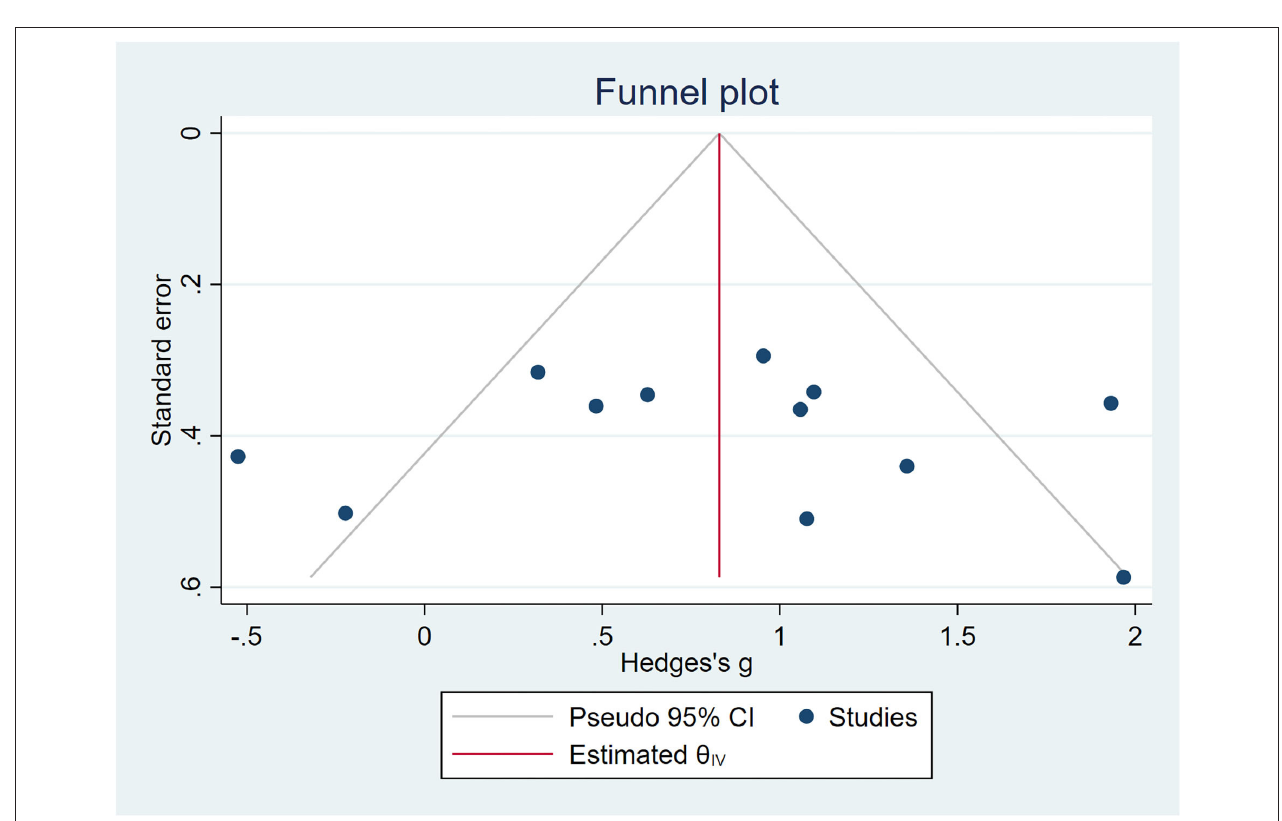
FIGURE 5 | A funnel plot showing publication bias among included studies. The funnel plot was plotted with SMD on the X-axis and the standard error on the Y-axis.